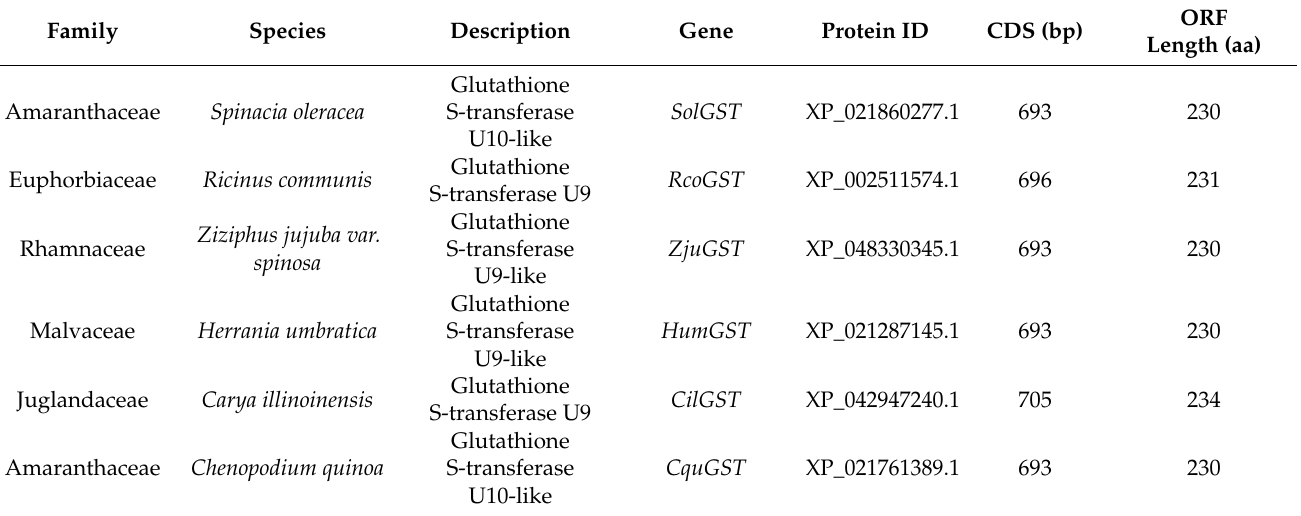
Table 3. Information sheet for 21